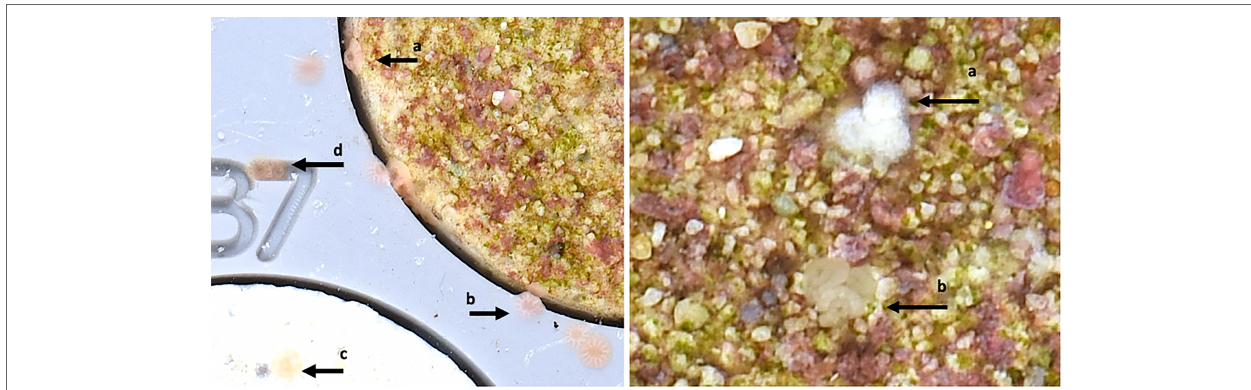
FIGURE 1 | (Left) Acropora tenuis spat showing various settlement locations, (a) spat on a conditioned settlement plug (b) spat on the PVC settlement tray, (c) spat on an unconditioned settlement plug, (d) spat in the crevice of the plug identification number. (Right) Examples of a cluster of opaque white dead A . millepora spat (a), and a cluster of alive A. millepora spat (b) on a conditioned settlement